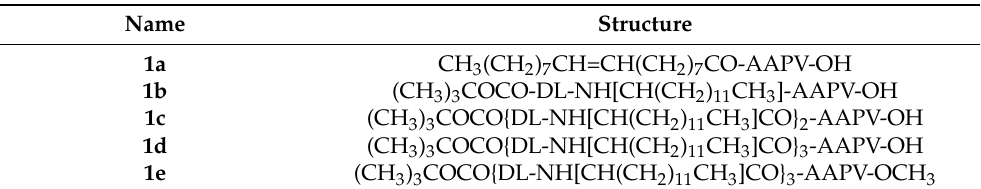
Table 4. Lipopeptides reported in Toth et al. [109] All structures are based on X-AAPV-Y fragment, with proper N- and C-terminal modifications (X and Y,